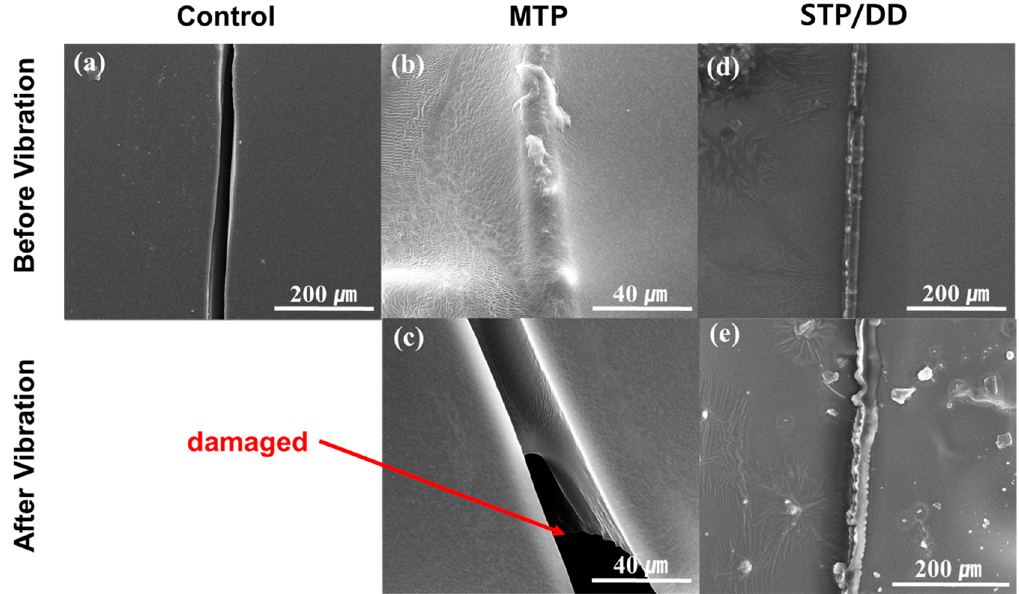
Figure 4. SEM images of the scratched region of ( a ) a control coating; ( b ) methacryloxypropyl-terminated polydimethylsiloxane (MTP)-based self-healing coating after scratching and healing; ( c ) MTP-based self-healing coating after scratching, healing, and vibration; ( d ) STP/DD-based self-healing coating after scratching and healing; and ( e ) STP/DD-based self-healing coating after scratching, healing and vibration.